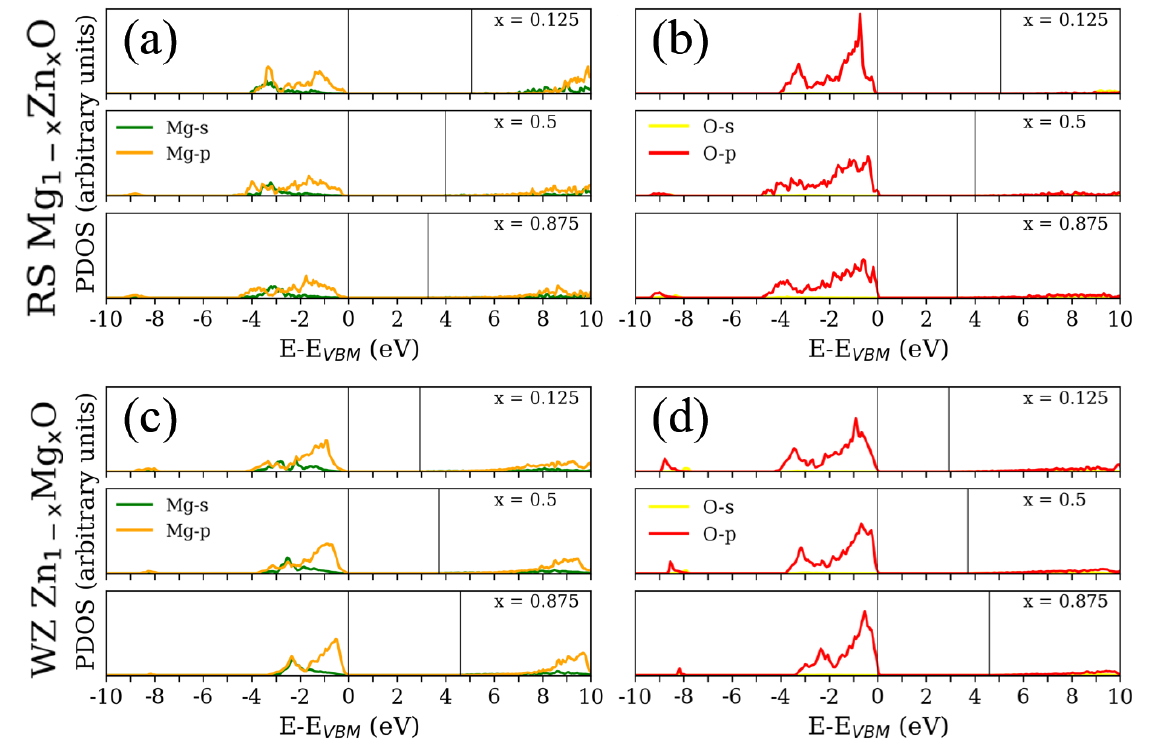
Figure 4. Partial density of states (PDOS) for ( a , b ) rocksalt (RS) Mg 1 − x Zn x O and ( c , d ) wurtzite (WZ) Zn 1 − x Mg x O at different concentrations (x = 0.125, 0.5 and 0.875) with respect to the valence band maximum (VBM). The colors of green, orange, yellow and red correspond to the Mg– s , Mg– p , O– s and O– p states, respectively. One vertical solid line is the VBM at 0 eV, and the other vertical solid line is the conduction band minimum above 0